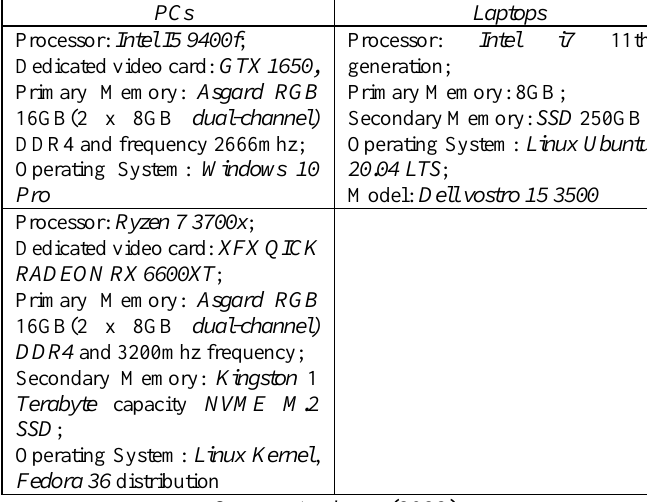
Table 1: List of peripherals